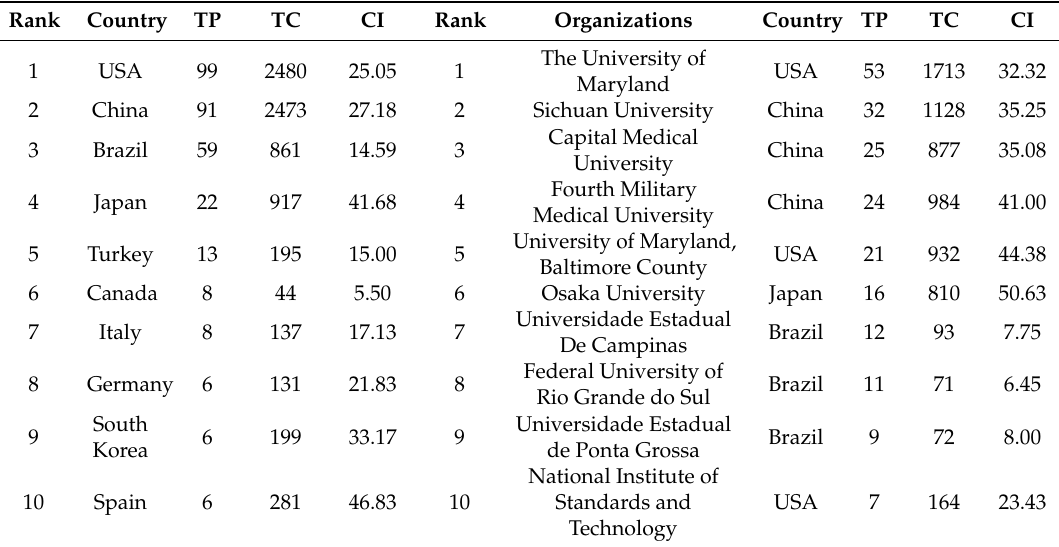
Table 1. Most influential countries and organizations in terms of total publications (TP), total citations